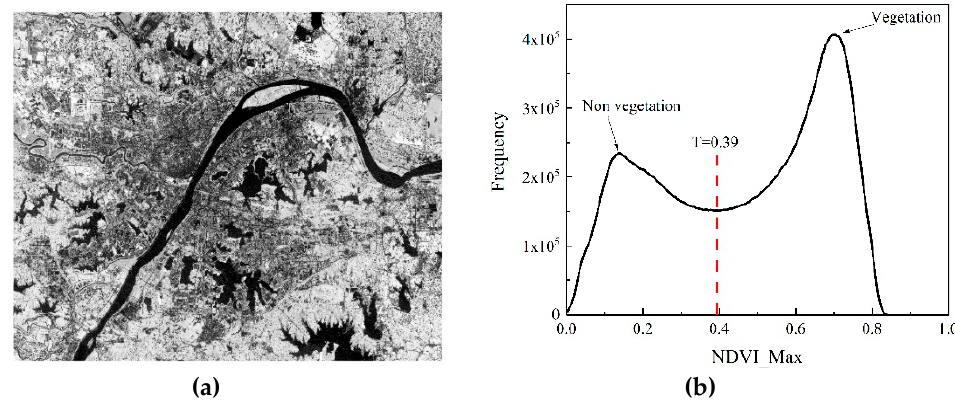
Figure 4. ( a ) The NDVI_max image; ( b ) the corresponding histogram.